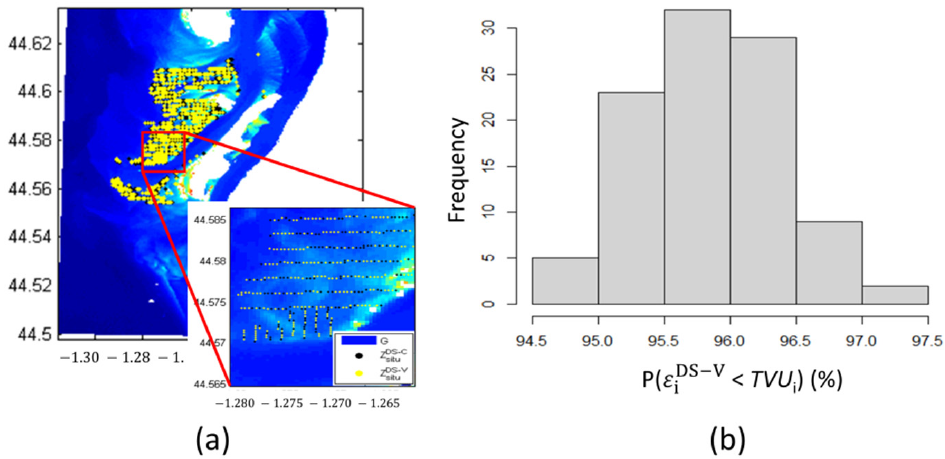
Figure 8. ( a ) Field bathymetry data point location of the matchup dataset DS associated with the 6 satellite images acquired in October 2017. Example of a random sampling where black points are associated with the calibration dataset ( Z DS − C ) and yellow points are associated with the val- idation dataset ( Z DS − V ). ( b ) Frequency distribution of the percentage of DS-V points showing an SDB error ( 𝜀 (cid:2919)(cid:2888)(cid:2903)(cid:2879)(cid:2906) ) lower than the total vertical uncertainty ( TVU i ) generated from a set of 100 random sam- plings.